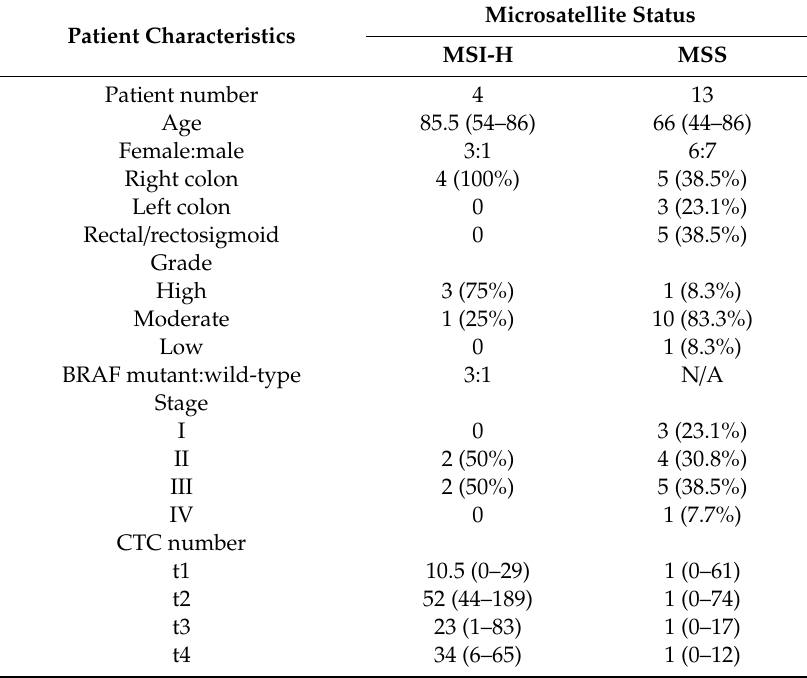
Table 1. Patient demographic, clinical, and surgical characteristics and circulating tumour cell (CTC) number. MSI-H, microsatellite instability-high; MSS, microsatellite